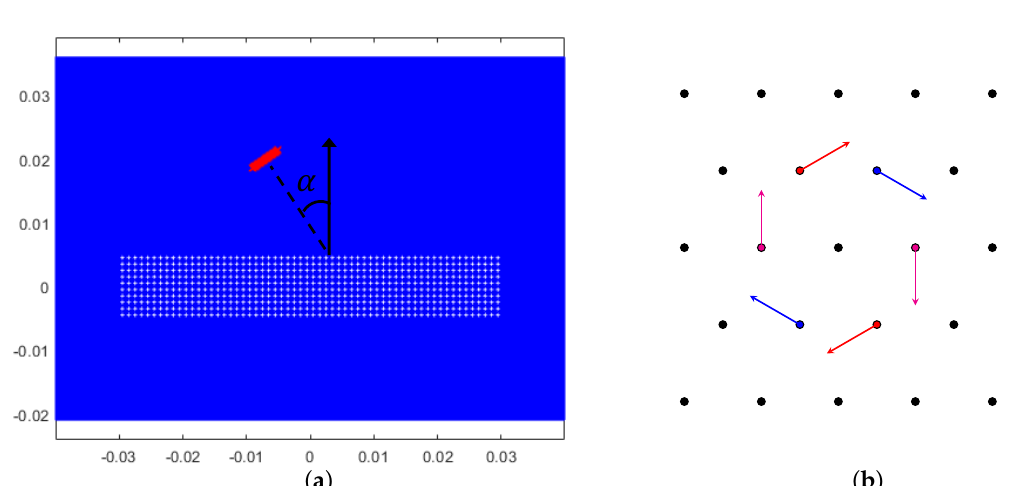
Figure 3. ( a ) Finite element model domain for shear wave Gaussian beam incidence. The angle α is 35 ◦ and the slab of metamaterial, sandwiched by homogeneous aluminium media, consists of 600 cross-shaped holes. Absorbing layers of length 8mm are applied to all sides of the domain. ( b ) Alternative point-source excitation for shear waves. The weighting applied to each of the six excitation nodes is highlighted by the directions of the